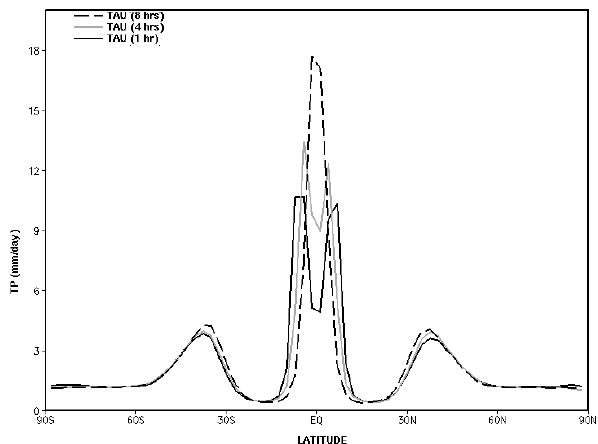
Fig. 1. Zonal averaged time mean total precipitation (TP) with three different TAUs, i.e. TAU (1h), TAU (4h), and TAU (8h). TAU stands for convective relaxation time